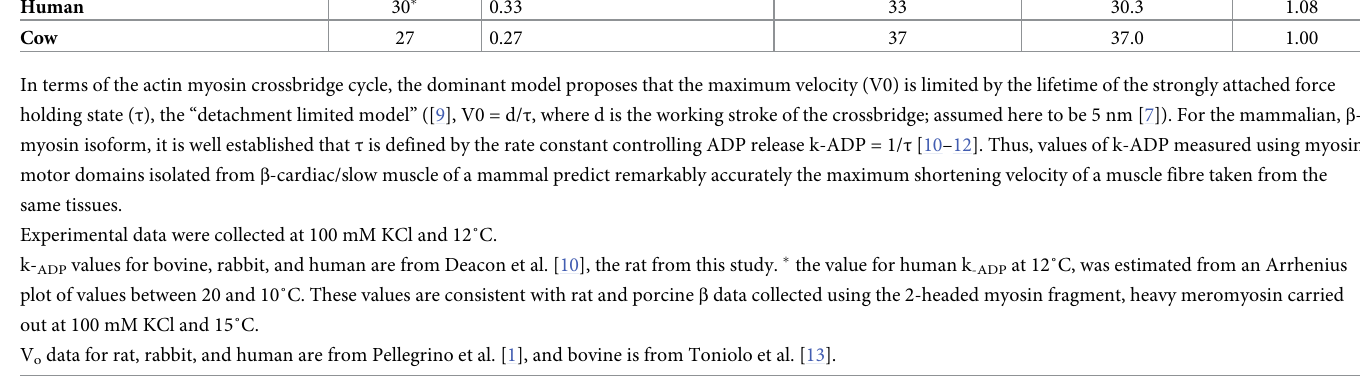
we considered the frequency of the consensus amino acid (black lines) and the number of dif- ferent amino acids present at each position (red lines). In the β -myosin motor domain, of the 800 amino acids, 632 were totally conserved, and a further 114 sites were highly conserved (i.e., fewer than 4/67 species have a different amino acid; for 69 of these sites, only 1 species